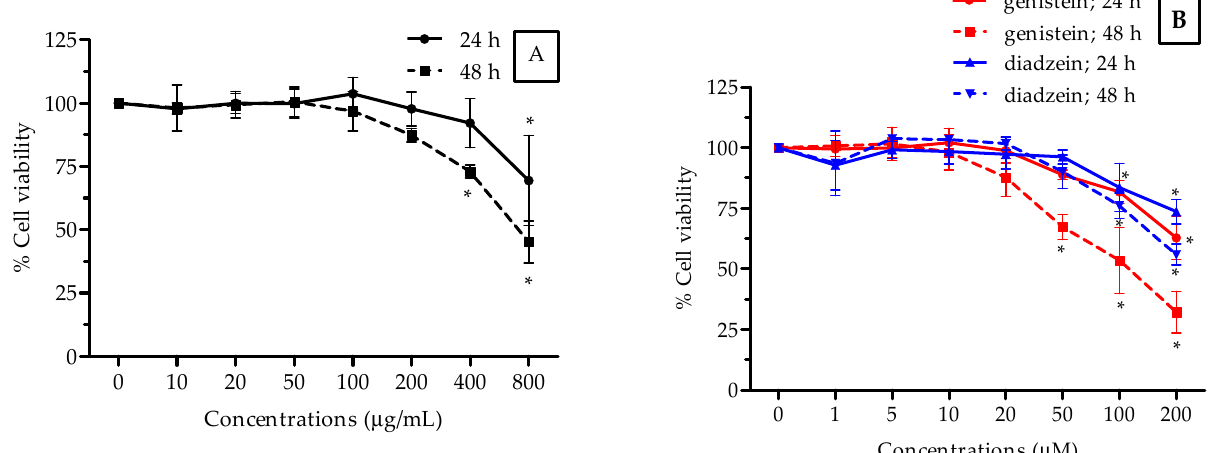
Figure 1. Cytotoxicity activity of ethanolic isoflavones extracts from Thua-nao ( A ) and genistein and diadzein ( B ) at various concentrations in HepG2 cells for 24 h and 48 h of incubation. All results are presented as the mean ( n = 3) ± SD. * p < 0.05 compared to the nontreatment control at each incubation time.